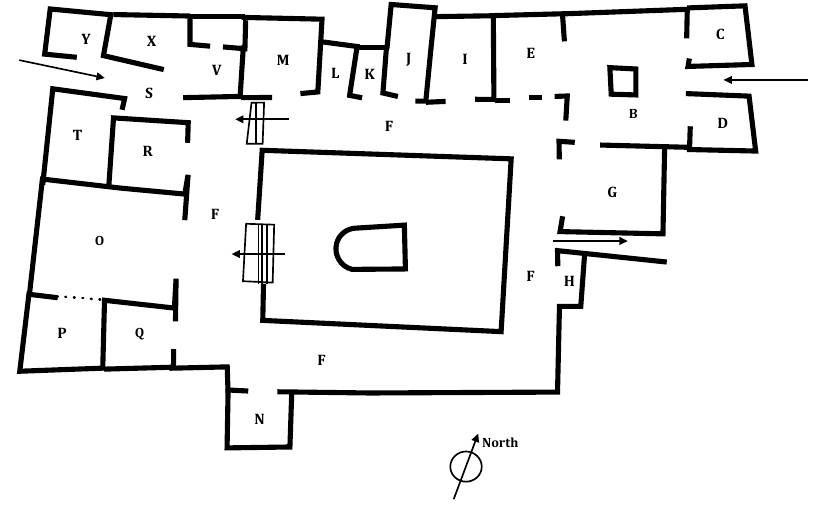
Figure 1. House of the Gilded Cupids, Plan, after Powers (2006). Created by Author.